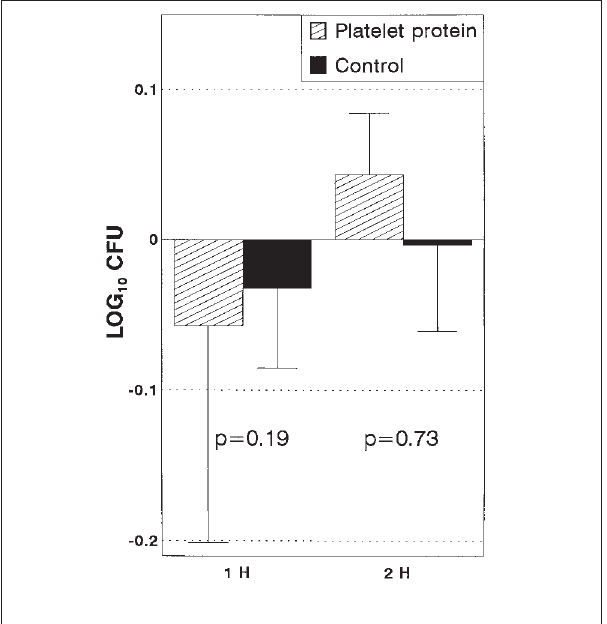
Color profile: Disabled Composite Default